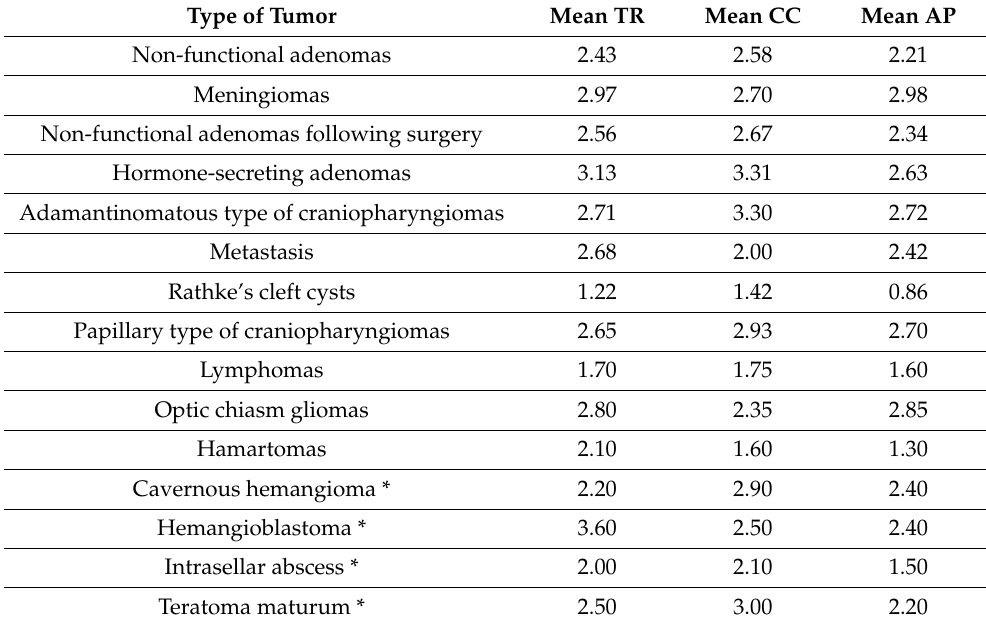
Table 4. Mean values of tumor size.